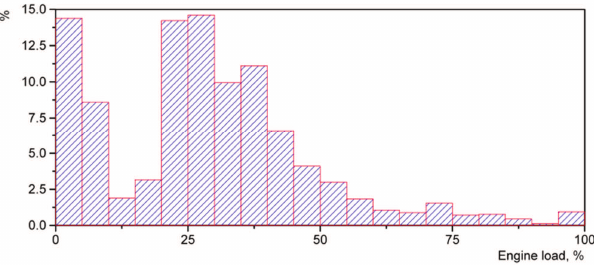
Fig. 10. Histogram for engine load in non-urban traffic